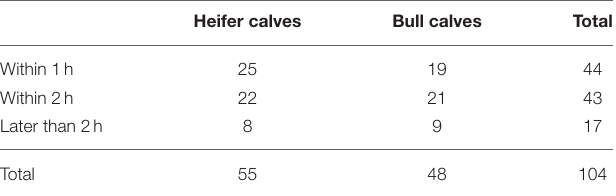
TABLE 7 | Time to which heifer and bull calves receive their first colostrum. Heifer calves Bull calves Total